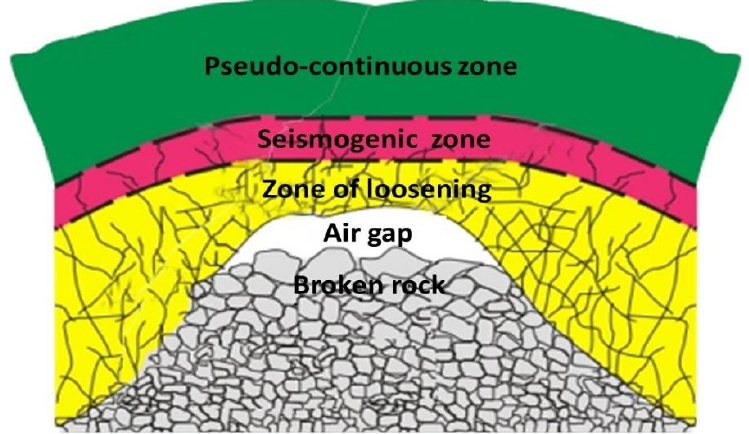
Figure 2. Block caving conceptual model which consists of the broken zone, the zone of loosening (yield zone), the seismogenic zone and intact rock (pseudo-continuous domain).